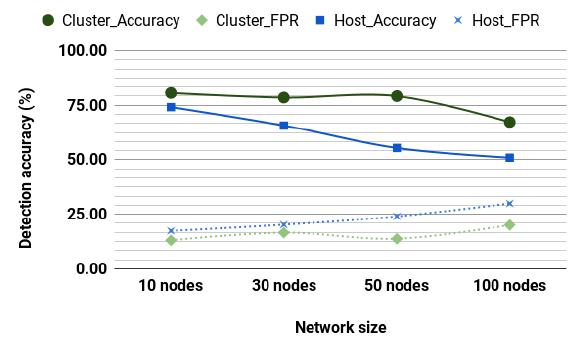
Figure 6. EllipticEnvelope and One-class SVM unsupervised detection (Max speed of 4.3